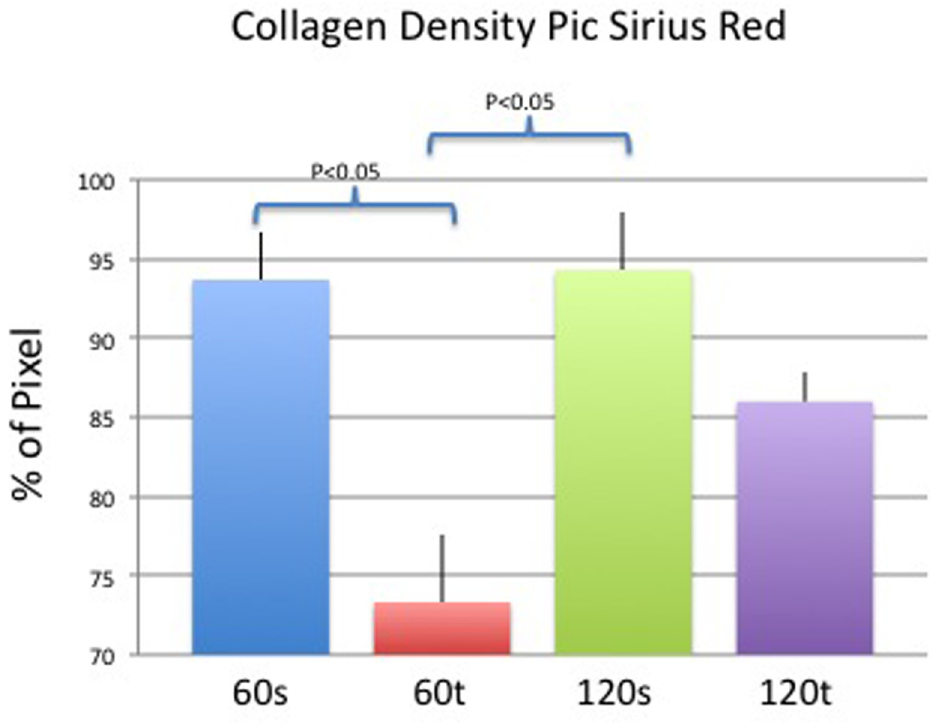
Fig 7. Mean (+/- standard deviation) collagen density in each study group. P < 0.05 was considered statistically significant.